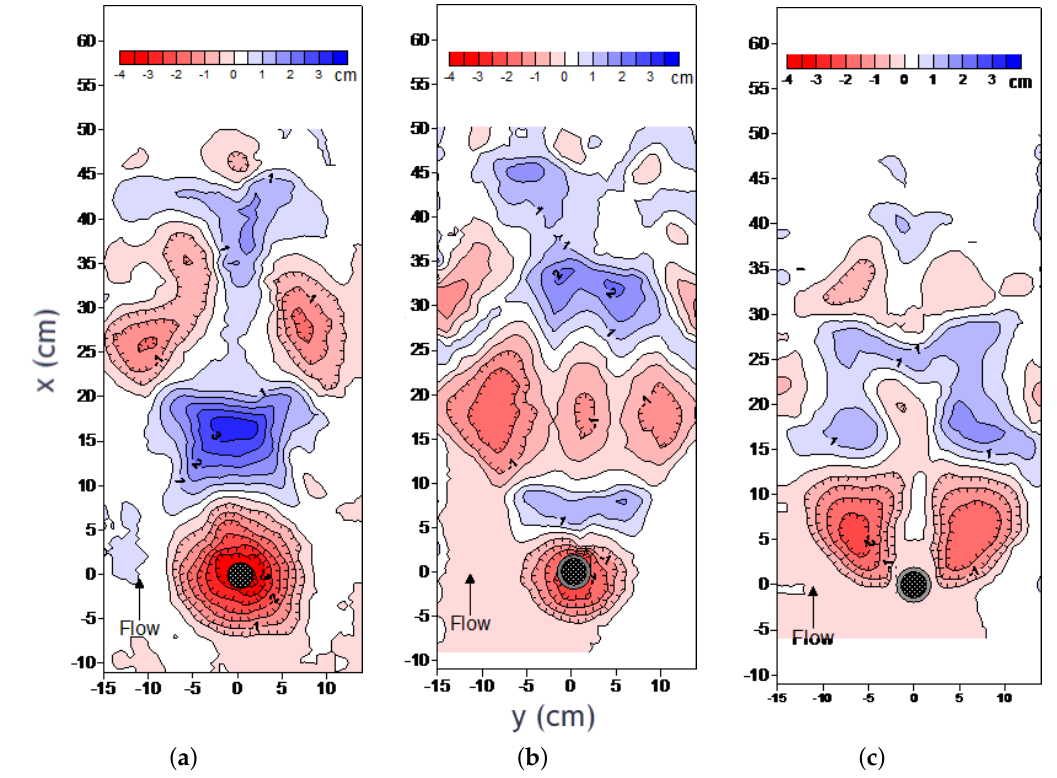
Figure 5. Observed scour pattern around the piers: ( a ) bridge pier without the hooked-collar; ( b ) pier with the hooked-collar positioned 0.25 b above bed; and ( c ) pier with the hooked-collar positioned at bed